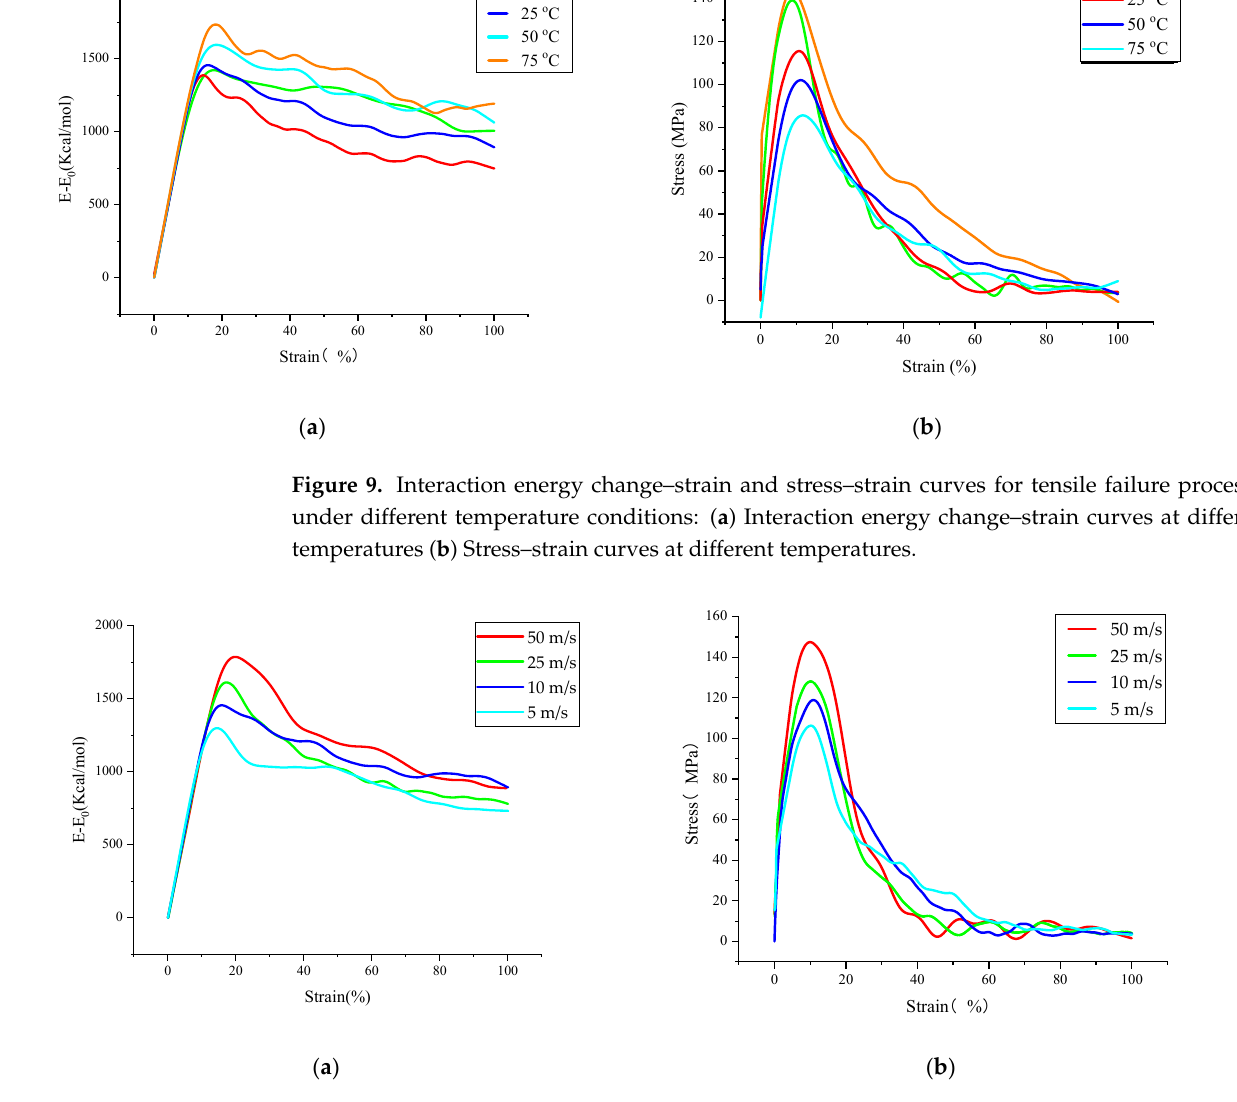
Figure 10. Interaction energy change–strain and stress–strain curves of tensile failure processes under different tensile rates: ( a ) Interaction energy change–strain curves at different rates ( b ) Stress–strain curves at different rates.